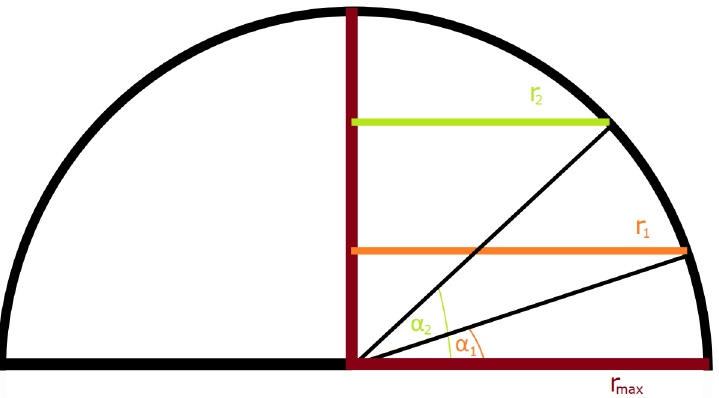
Figure 2. A hemisphere with a microphone on top and two microphone arrays arranged in circles with radii r 1 and r 2 .